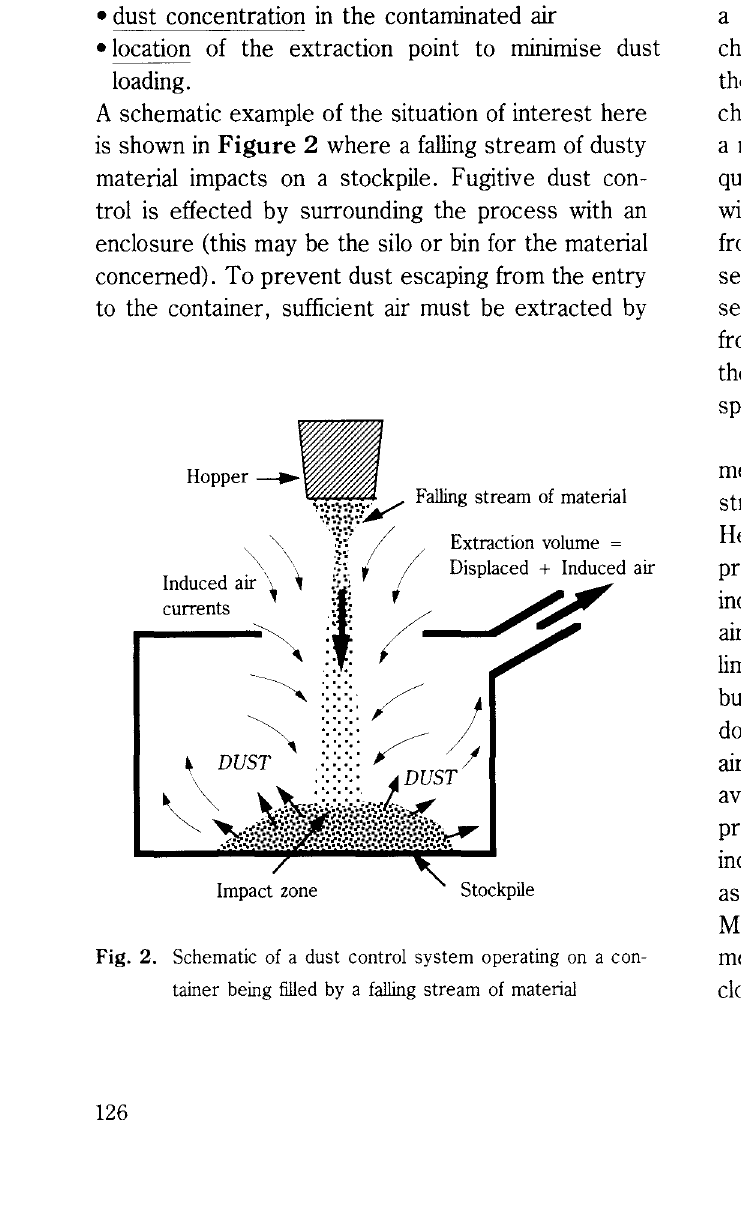
Fig. 2. Schematic of a dust control system operating on a con tainer being filled by a falling stream of